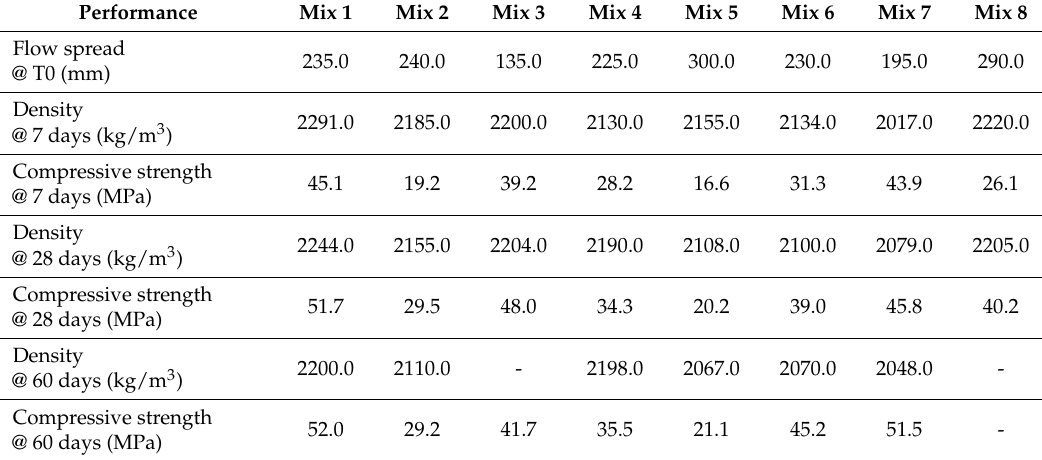
Table 3. Performance of optimized alkali-activated